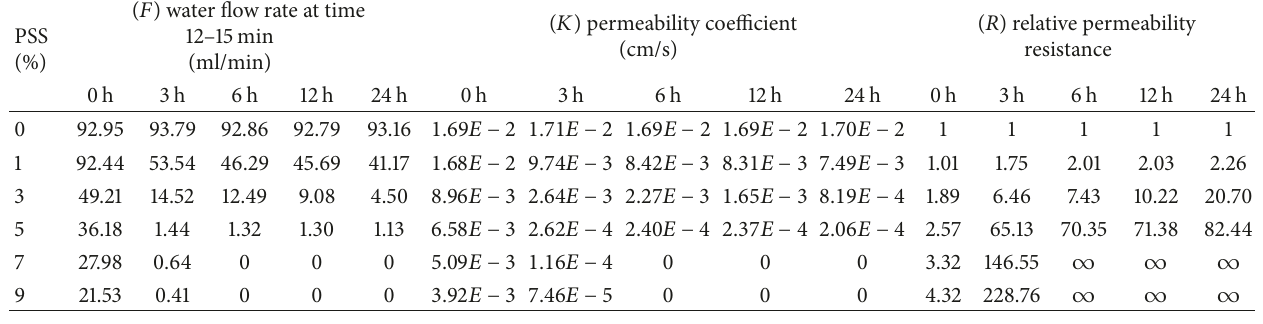
Table 3: The evaluation parameters of specimens with different curing times in single-hole permeability tests.